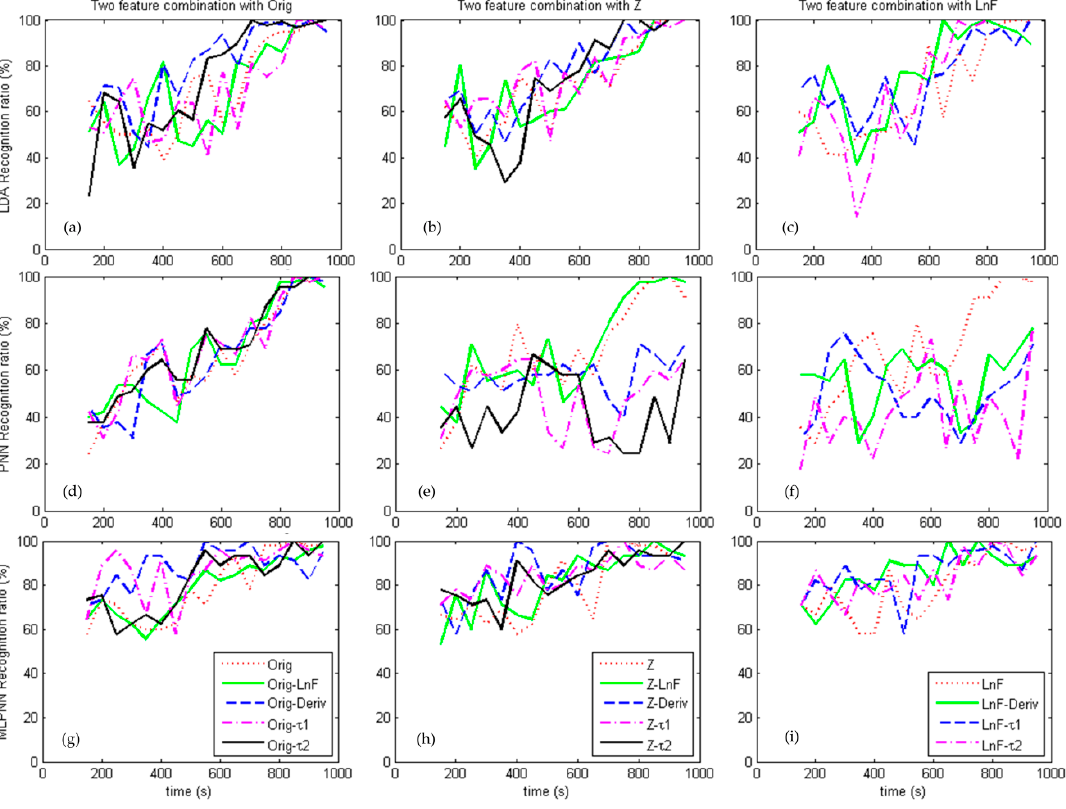
Figure 7. Linear Discriminant Analysis (LDA), Probabilistic Neural Network (PNN), and Multilayer Perception Neural Network (MLPNN) recognition based on combination of feature. From left to right, LDA recognition ratio based on two feature combinations with ( a ) Orig ; ( b ) Z ; ( c ) LnF , PNN recognition ratio based on two feature combinations with ( d ) Orig ; ( e ) Z ; ( f ) LnF , and MLPNN recognition ratio based on two feature combinations with ( g ) Orig; ( h ) Z; and ( i ) LnF .